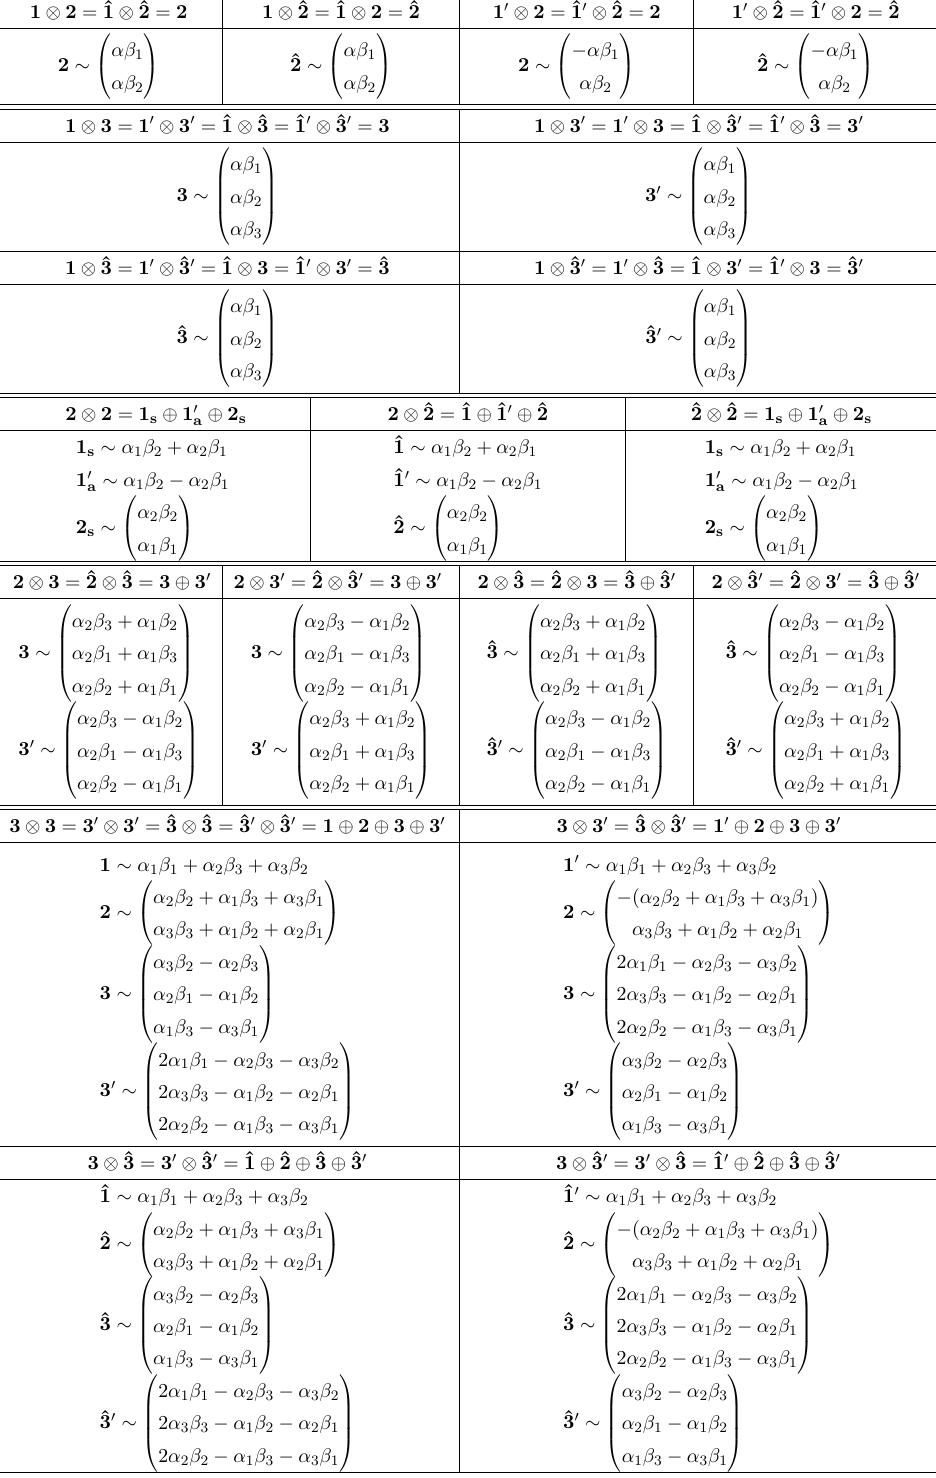
Table 4 . The Kronecker products and Clebsch-Gordan coefficients of the S 4 × Z 2